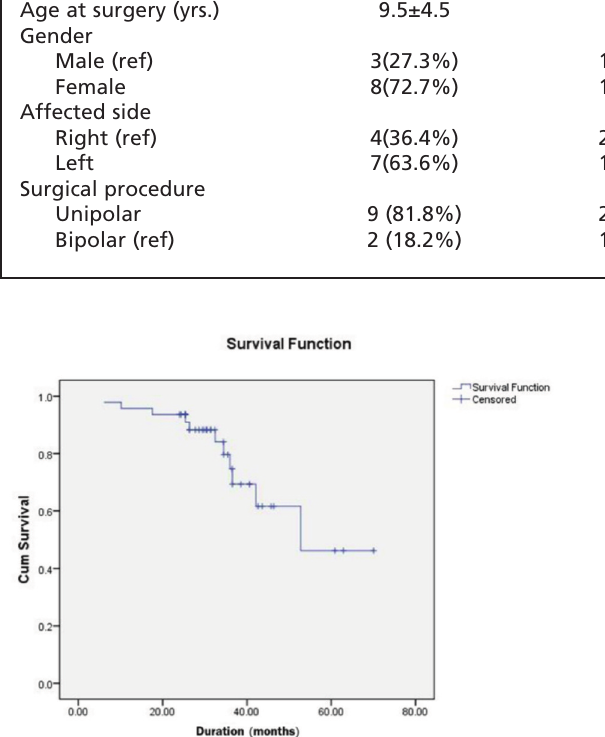
Survival curve for all congenital muscular torticollis Fig. 1: patients. The first case of recurrence (1/11) was occurred at 6.1 months and last case of recurrence (11/11) was occurred at 52.8 months